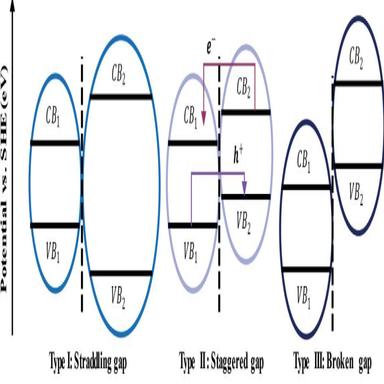
Possible heterojunctions between two semiconductors. Subscripts 1 and 2 represent semiconductors 1 and 2, respectively. Source: Adapted from: Cao et al. 2016.